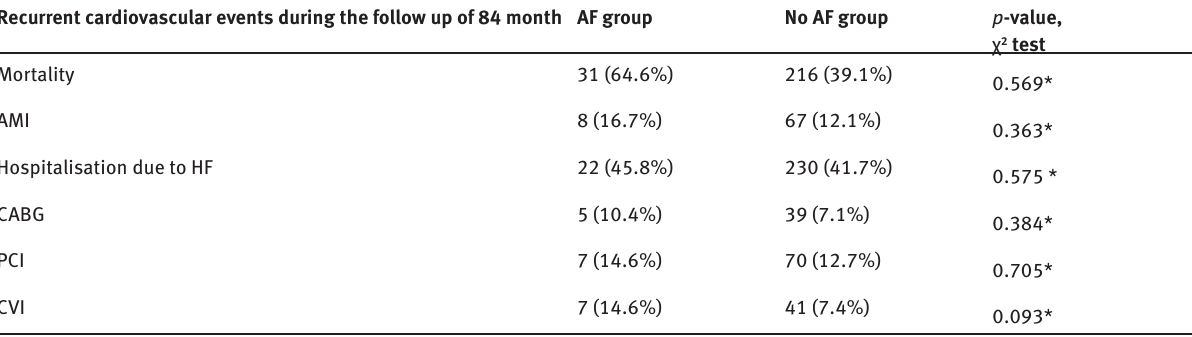
Table 6: Recurrent cardiovascular events during the follow-up period of 84 month Recurrent cardiovascular events during the follow up of 84 month AF group No AF group p -value,